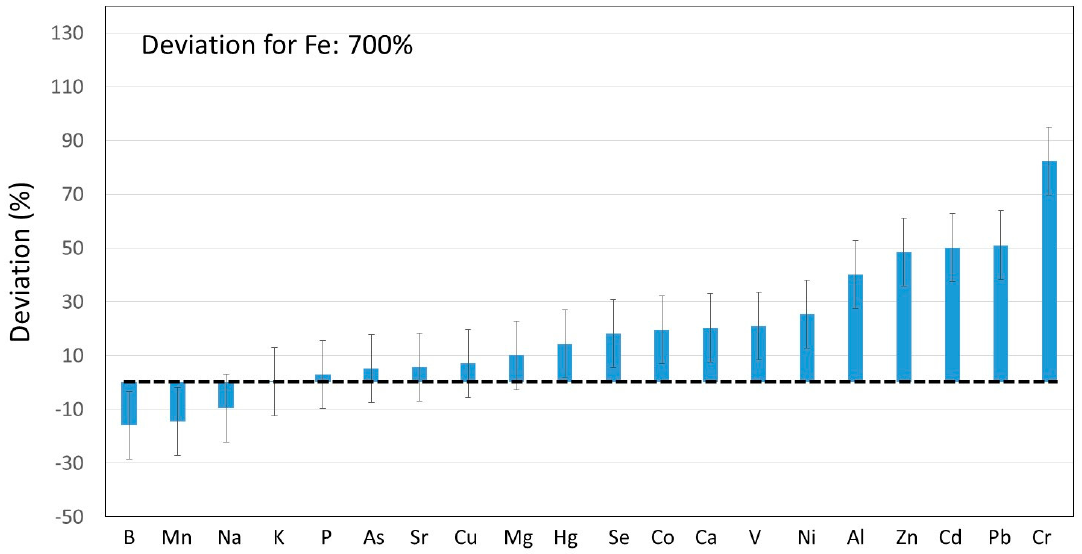
Figure 3. Deviation percentages between the elemental mass contained in the different fractions of the winemaking process, with respect to the mass contained in the grapes and yeast.